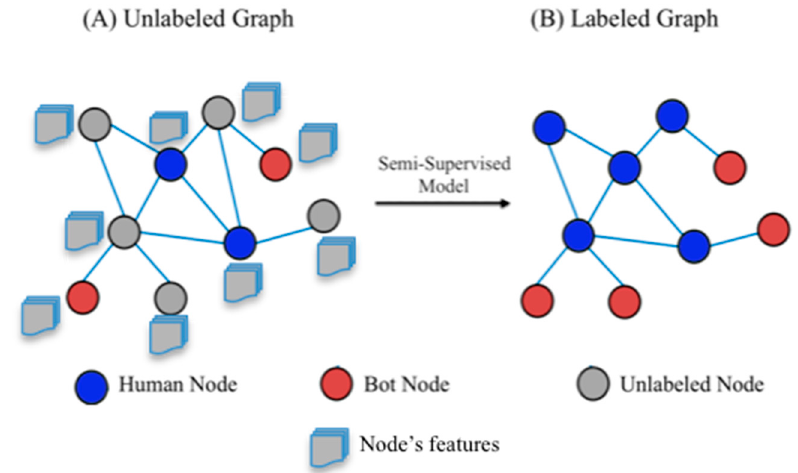
Figure 1. Semi-supervised learning uses nodes’ embedding to predict the node class. Both labeled and unlabeled nodes are used in SSL.